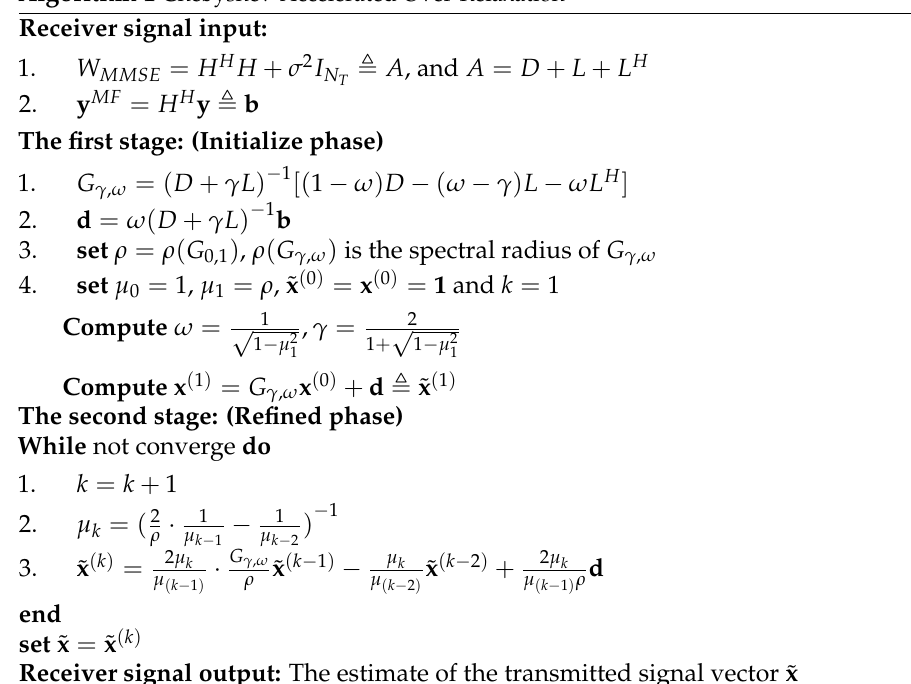
Figure 1. The block diagram of the proposed two-stage detection scheme. Algorithm 1 Chebyshev-Accelerated